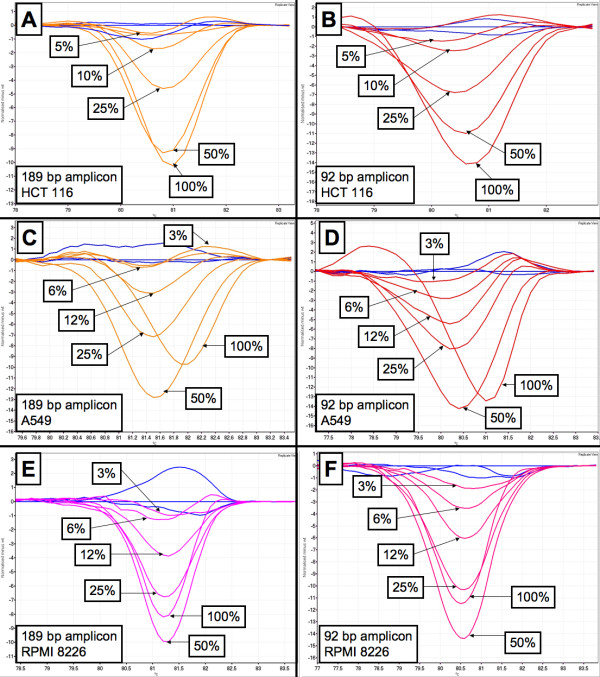
Sensitivity of the KRAS HRM assay for different amplicons. Panel A: The HCT116 dilutions were compared to the median wild-type control sample to produce the difference plot for the 189 bp amplicon. Panel B: The HCT116 dilutions were compared to the median wild-type control sample to produce the difference plot for the 92 bp amplicon. Panel C: The A549 dilutions were compared to the median wild-type control sample to produce the difference plot for the 189 bp amplicon. Panel D: The A549 dilutions were compared to the median wild-type control sample to produce the difference plot for the 92 bp amplicon. Panel E: The RPMI8226 dilutions were compared to the median wild-type control sample to produce the difference plot for the 189 bp amplicon. Panel F: The RPMI8226 dilutions were compared to the median wild-type control sample to produce the difference plot for the 92 bp amplicon.